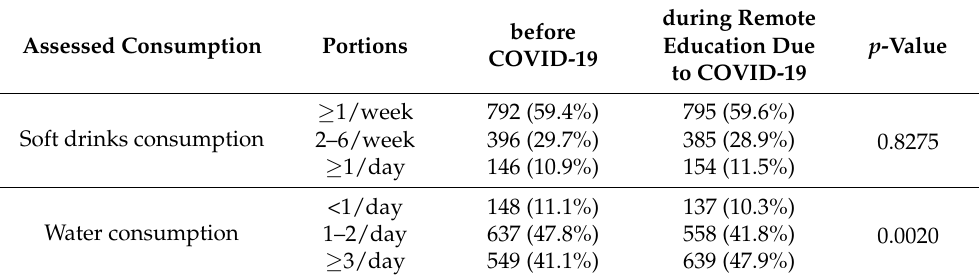
Table 3. Analysis of declared soft drinks and water consumption in the studied group of Polish adolescents within Diet and Activity of Youth during COVID-19 (DAY-19)